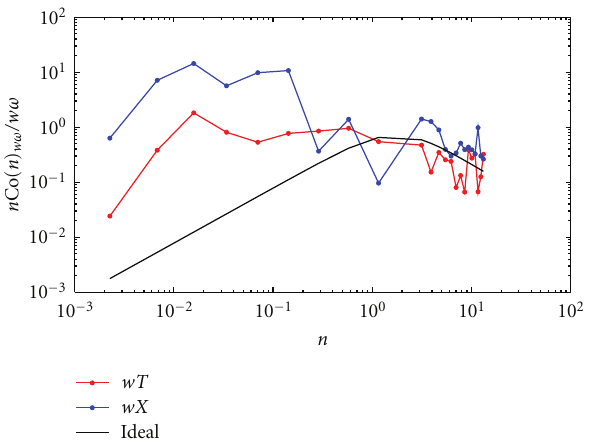
Figure 4: Relative flux contribution for EC measurements at 22 m Figure 2: Averaged smoothed and normalized temperature cospec- height on the Mace Head tower. Footprint distance from the tra ( wT , in red) and O 3 cospectra ( wX , in blue) for all O 3 flux values measurement location is shown on the x -axis. The tidal zone is between | 0 . 01 | and | 0 . 02 | μ gm − 2 s − 1 . The symbols T , X , w , n , and represented by the two vertical black lines. ω represent temperature, O 3 signal, vertical wind speed component, and frequency, respectively. The theoretical (ideal) slope according to Kaimal et al. [27] displaying a − 4/3 power law is also shown.